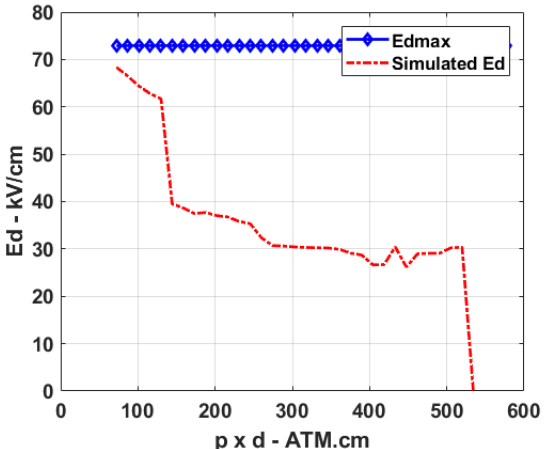
Figure 9. The simulated electric field of R410A GIT for selected point. Analysis of a lightning impulse is also required to determine the worst-case electric field strength.